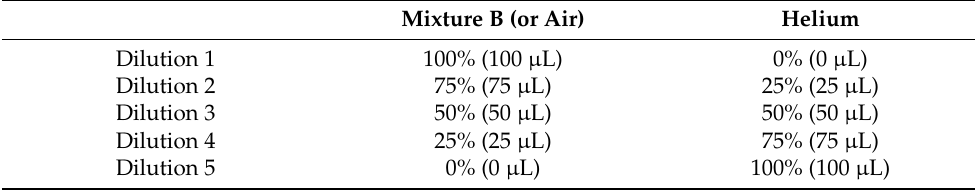
Table 2. Table of used dilutions of the mixture B in